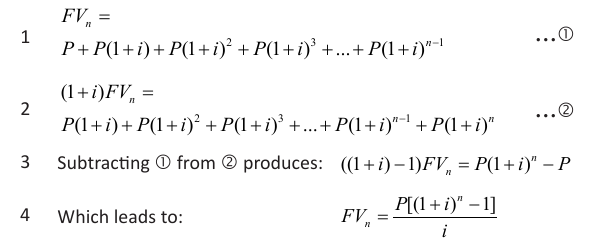
BOX 1: Elimination method to derive formula for future value of an ordinary